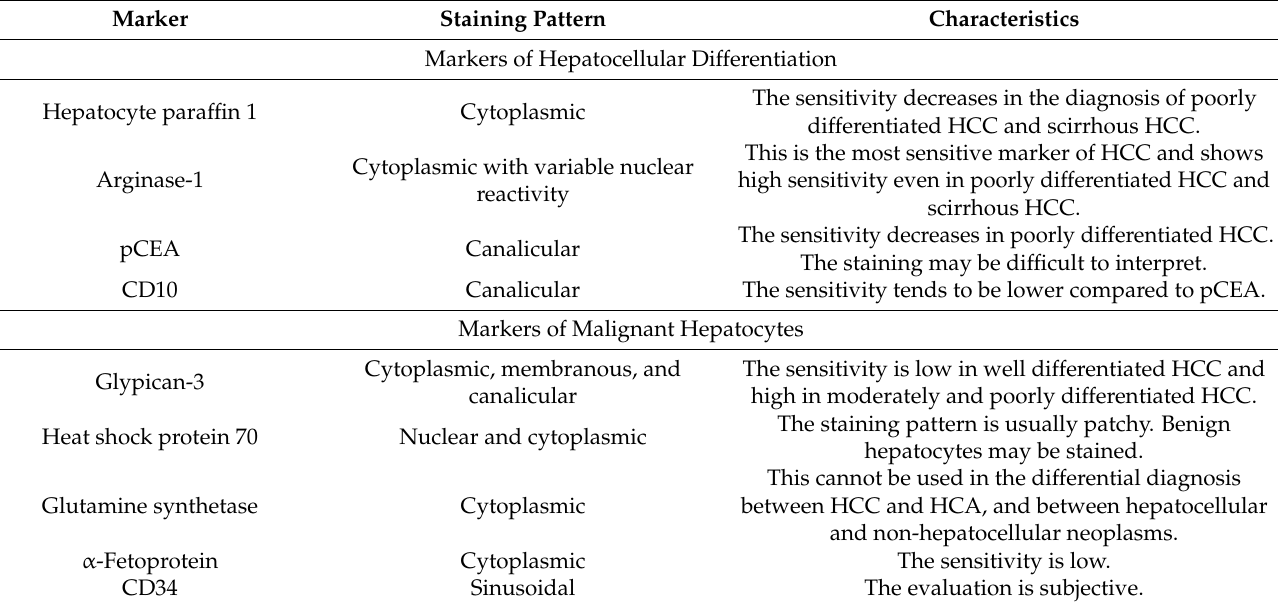
Table 1. Immunohistochemical markers of